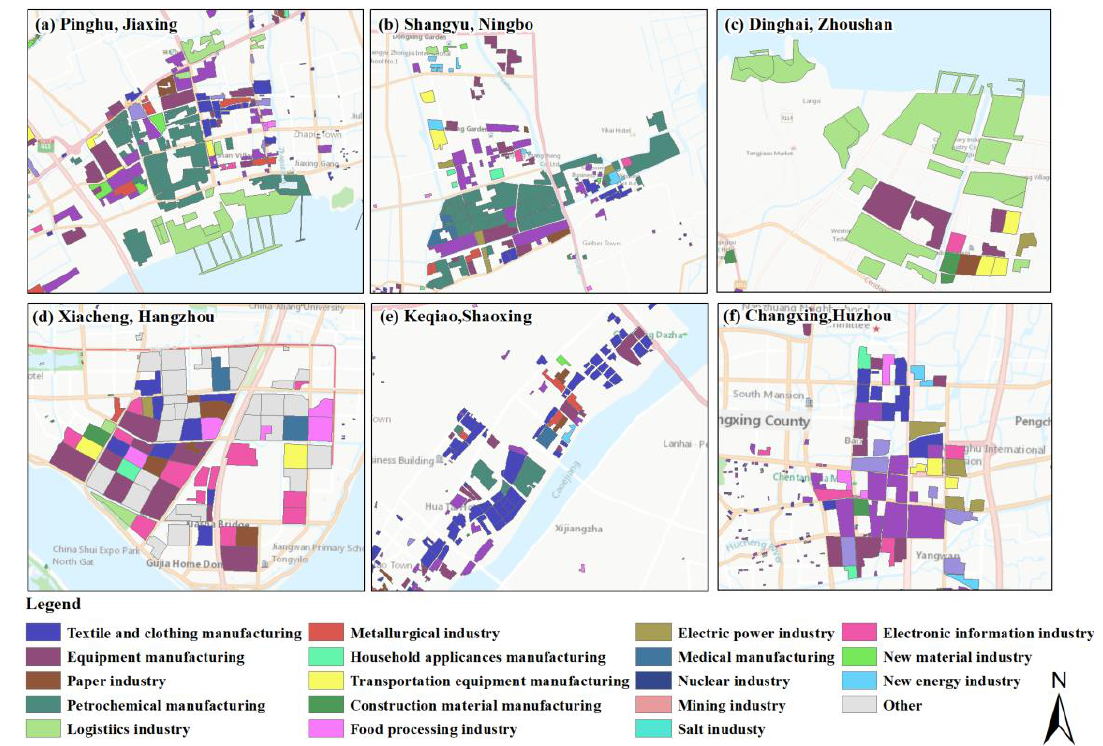
Figure 8. Identification of industrial intra-structure across the UAHB from 2010 to 2015.